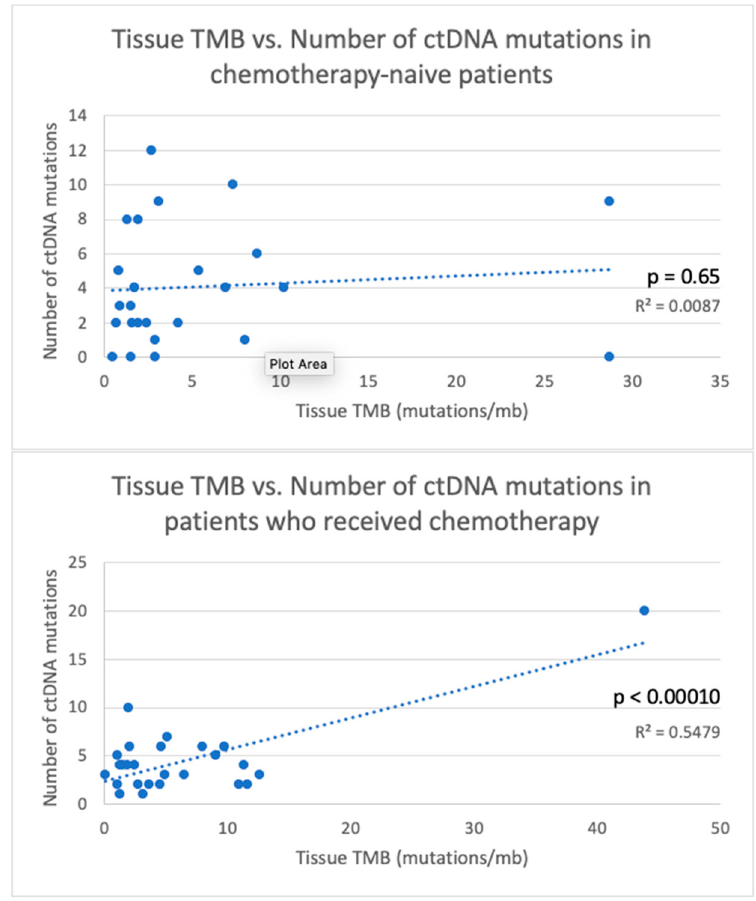
Figure 1. Scatter plots showing the relationships between tissue tumor mutation burden (TMB, mut/mb) and the number of ctDNA mutations. TMB was positively correlated with the number of ctDNA mutations only in those who received chemotherapy prior to tissue next generation sequencing or ctDNA